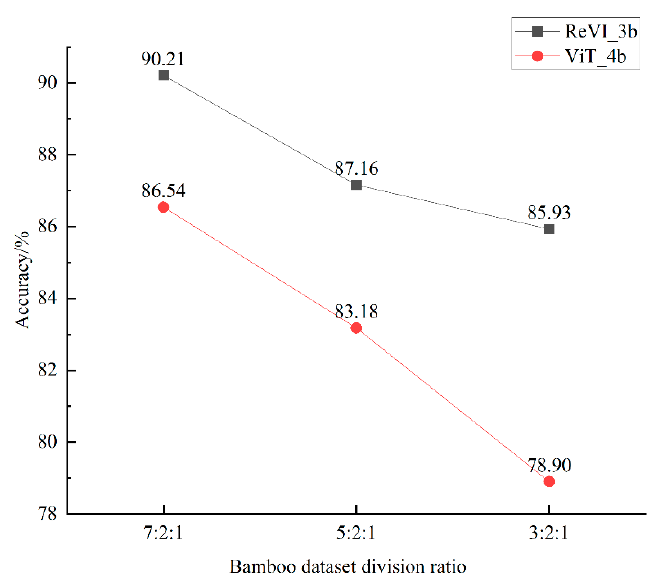
Figure 10. Accuracy of ReVI_3b and ViT_4b on the test dataset with three division ratios.